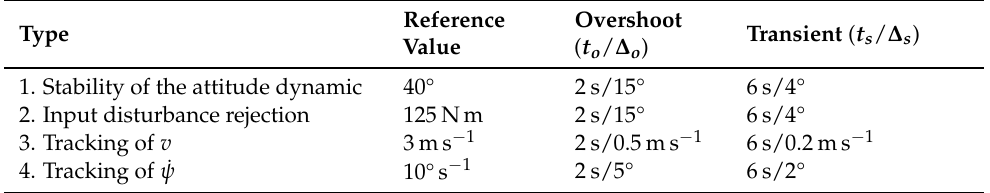
Table 1. Specification of the dynamic properties of the